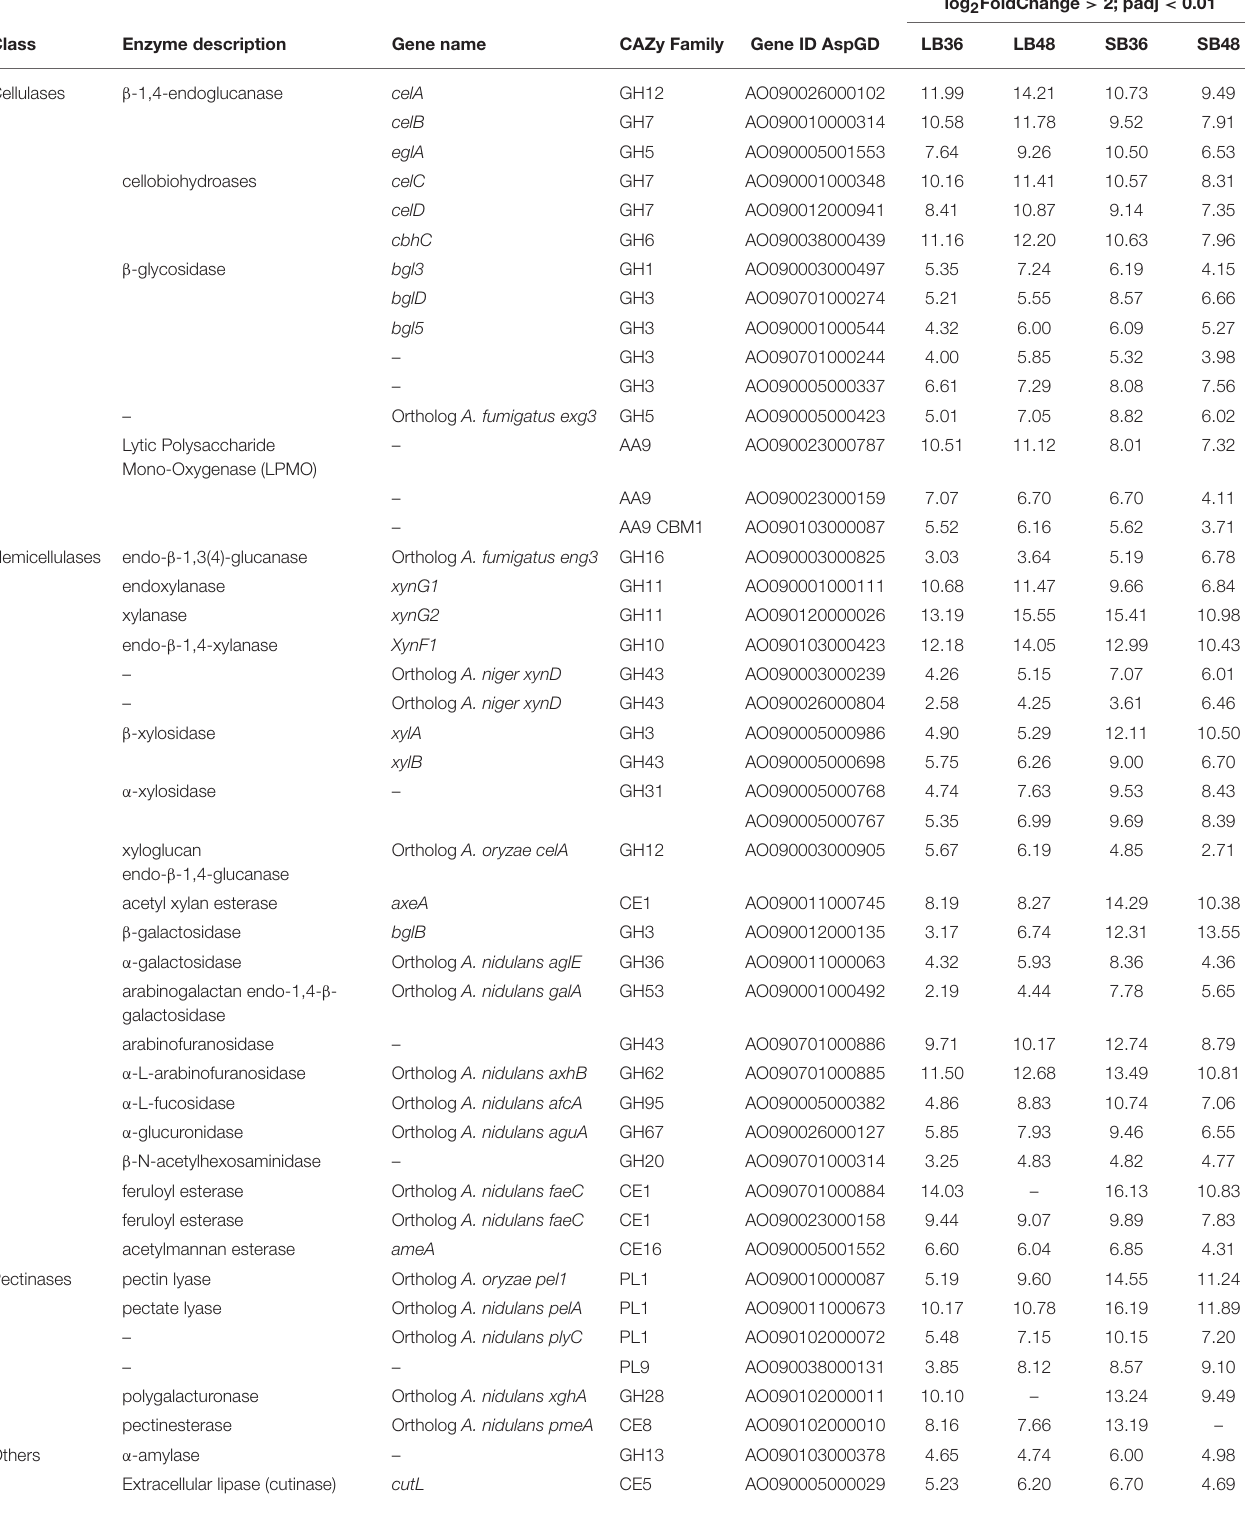
TABLE 1 | CAZyme-encoding genes with significant increased expression after growth in treatments with steam exploded bagasse, in comparison with